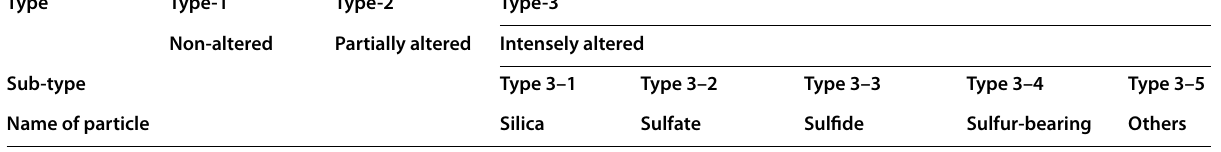
Table 4 Type classifications of volcanic ashes from the 2018–2019 eruption at Kuchinoerabujima